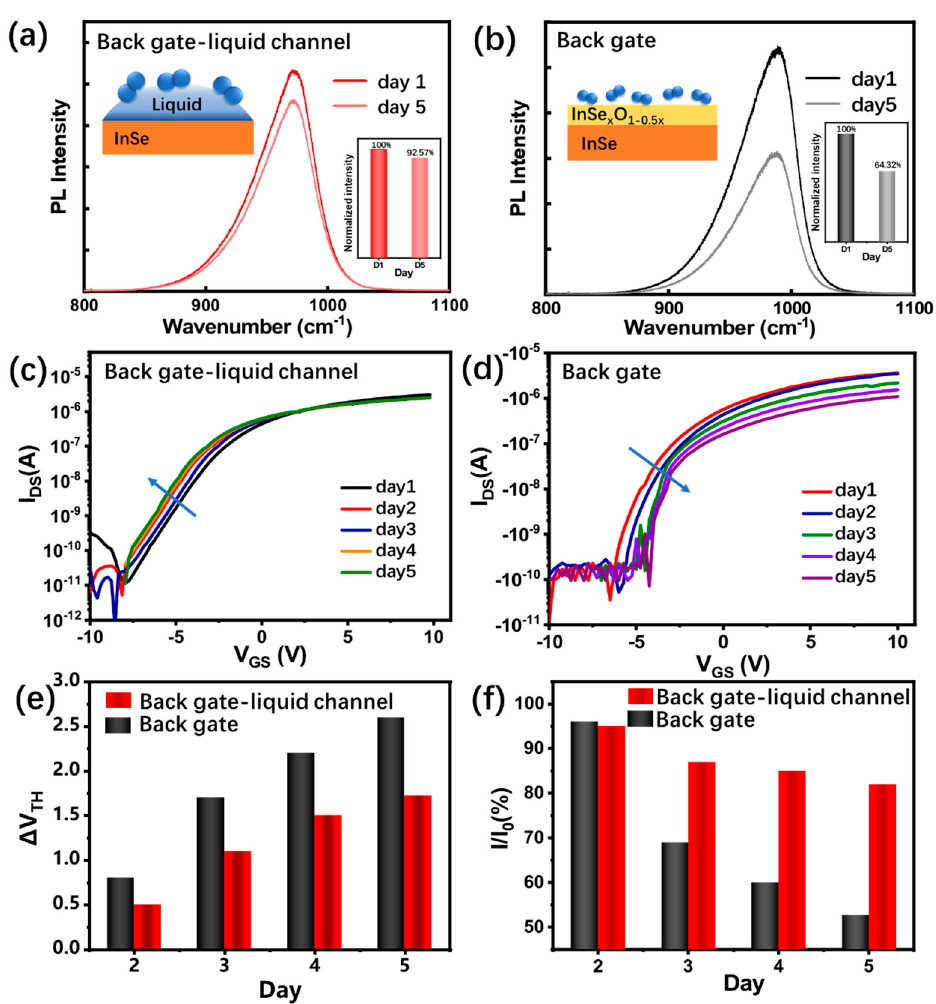
Figure 4. PL spectra of InSe before and after storage for five days in ( a ) liquid and ( b ) atmosphere. Transfer curves before and after storage for five days in ( c ) air and ( d ) liquid. ( e ) The threshold voltage shift and ( f ) the output current change at V GS = 10 V for the InSe-FETs over storage time.